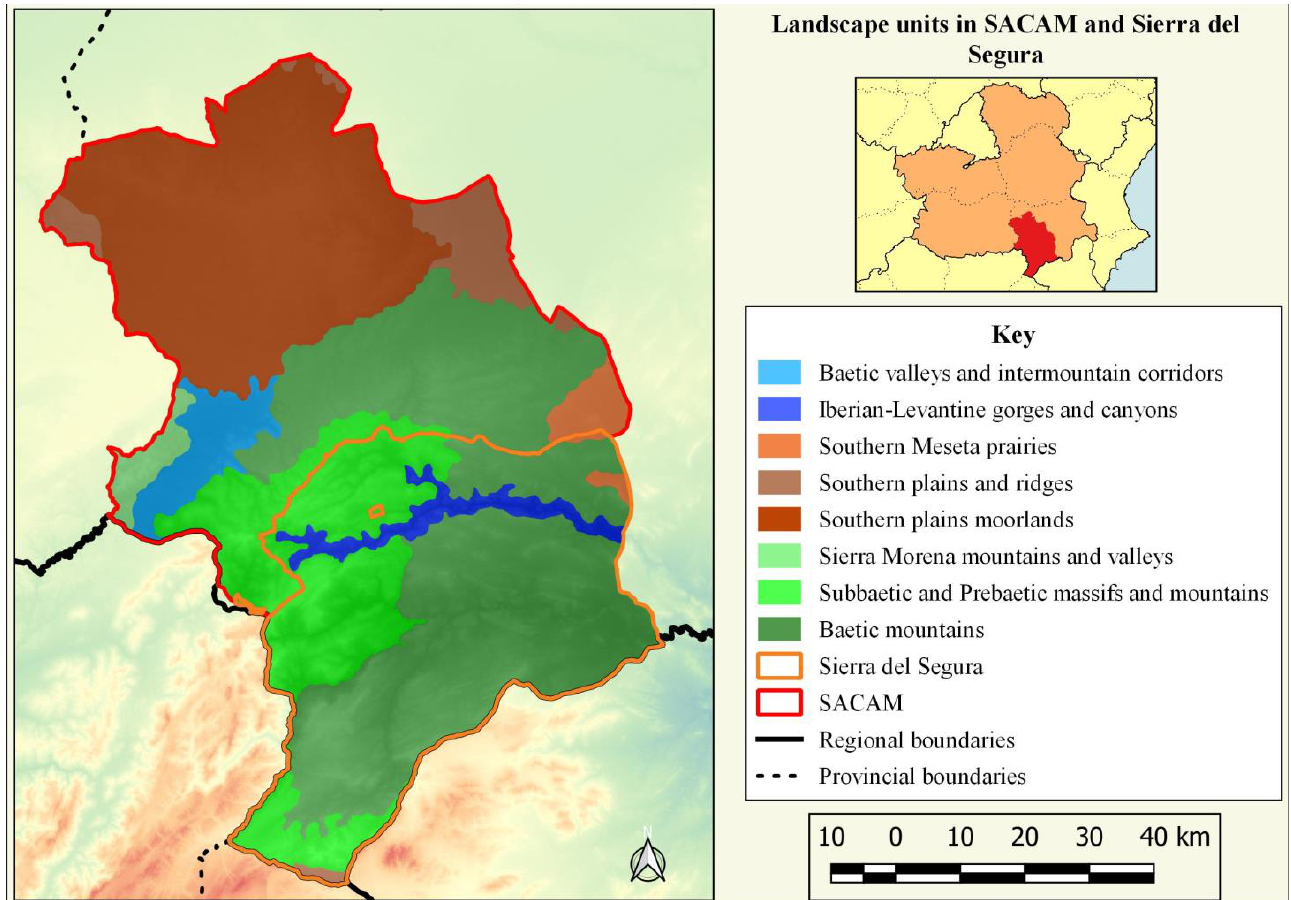
Figure 4. Landscape units (Source: Own preparation).